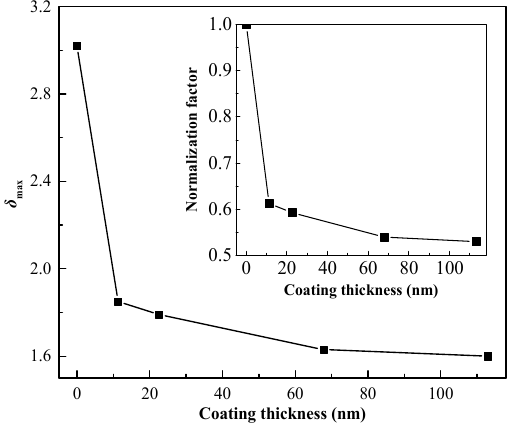
Figure 5. The δ max of Al sheet coated by FC coatings with different thickness.